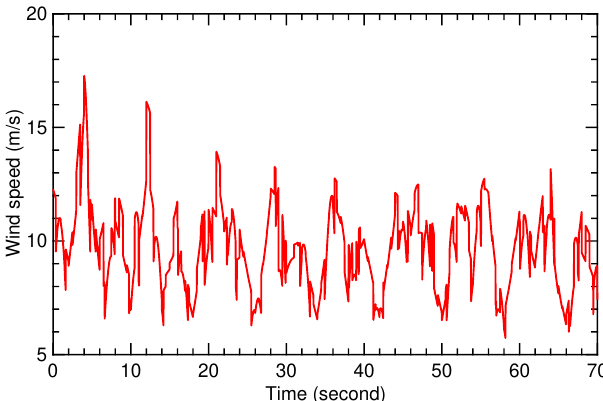
Figure 9. Time history for wind speed during flight condition I.